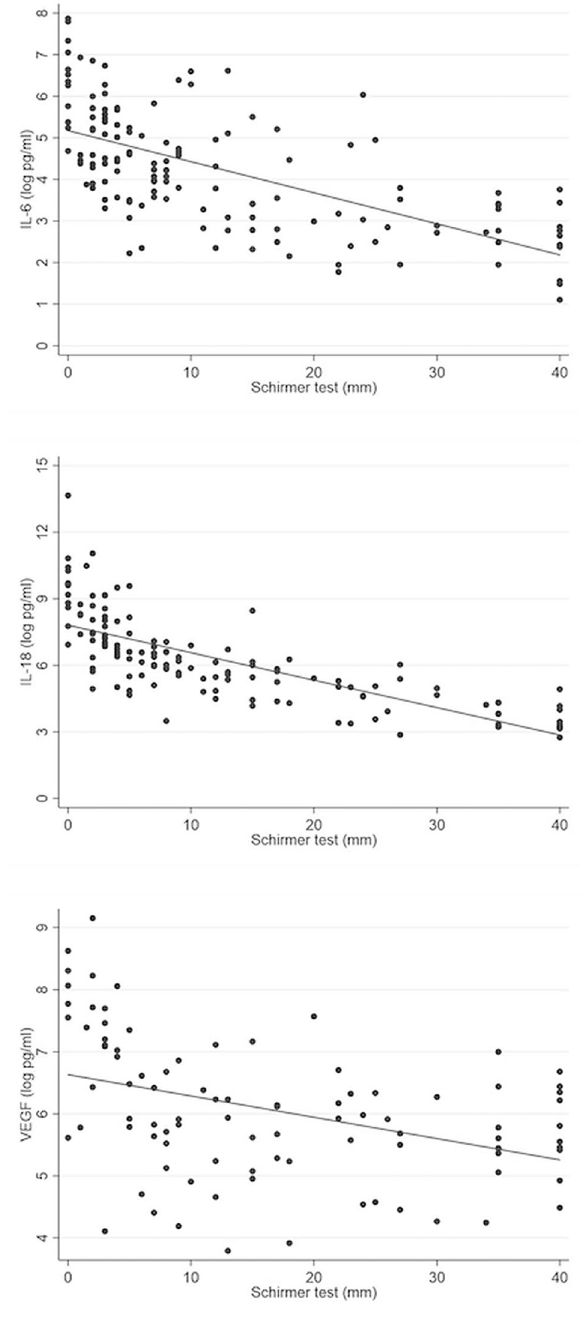
Figure 3. Scatter plot of correlation between Schirmer test and concentration of tear cytokine (after logarithmic transformation). ( A ) Correlation between Schirmer test (mm) and concentration of IL-6 (log pg/ml); ( B ) Correlation between Schirmer test (mm) and concentration of IL-18 (log pg/ml); ( C ) Correlation between Schirmer test (mm) and concentration of VEGF (log